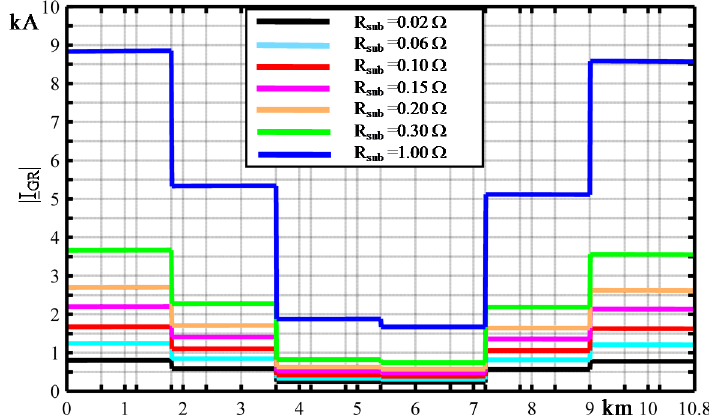
Figure 7. Faulted UGC: ground return current magnitudes along the line (CB with PTs) for different substation grid resistances; FAULT at